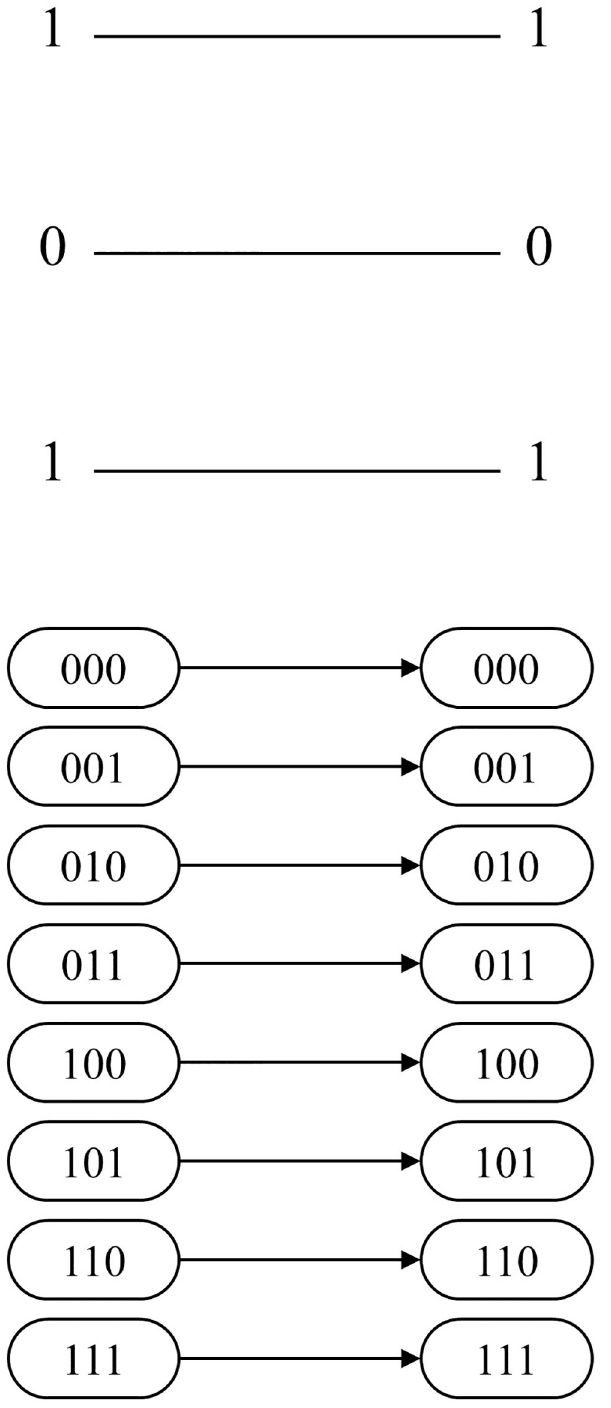
Fig 4. 3-qubit example of MCT gate-network conversion: CASE1